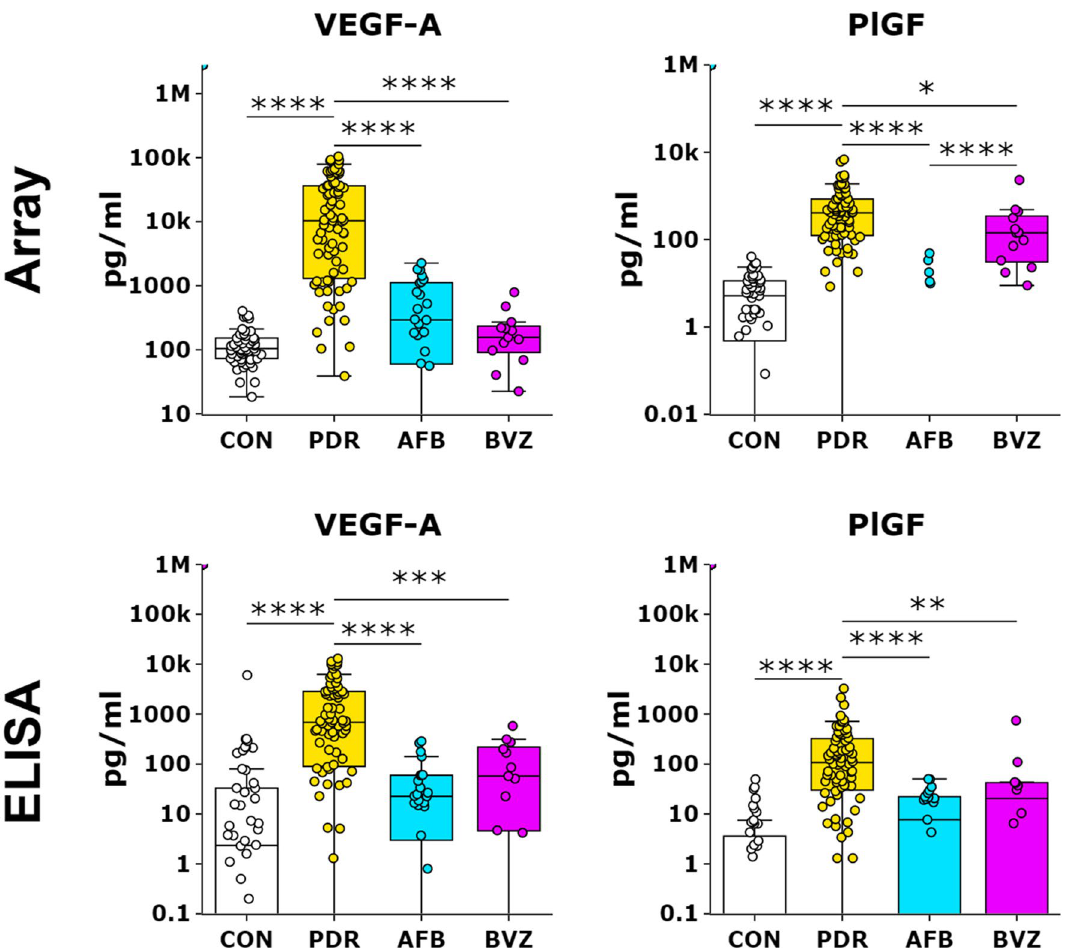
Figure 2. Effect of pre-operative anti-VEGF treatment on VEGFA and PlGF protein concentrations. Box plots indicate median, min and max and 1st and 3rd quartile. Protein concentrations for controls, untreated PDR patients (PDR), PDR patients treated with AFB (AFB) and PDR patients treated with BVZ or RZB (BVZ) are presented as pg/ml in log10 scale. Graphs in the upper row were obtained from array data, graphs in the lower row from ELISA data. * P < 0.05; ** P < 0.01; *** P < 0.001; **** P <